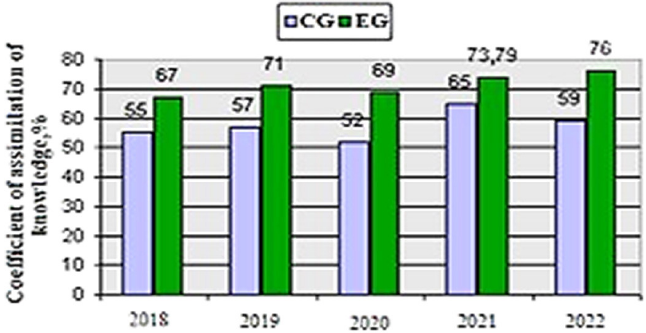
Fig. 2. Dynamics of indicators of quality of educational and research achievements of